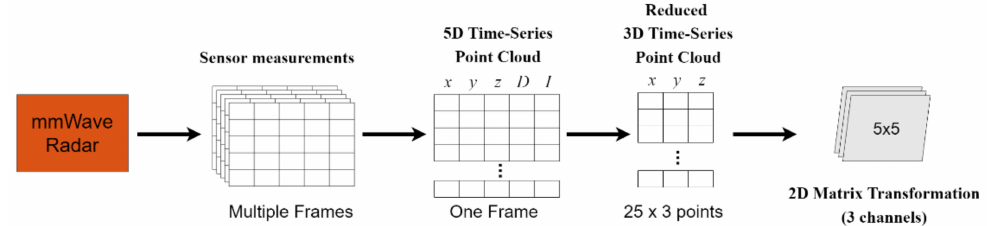
Figure 2. Pre-processing of the MARS radar dataset. We empirically decided the dimension of the input to be 25 × 3. Then, 25 rows were reshaped into a 5 × 5 × 3